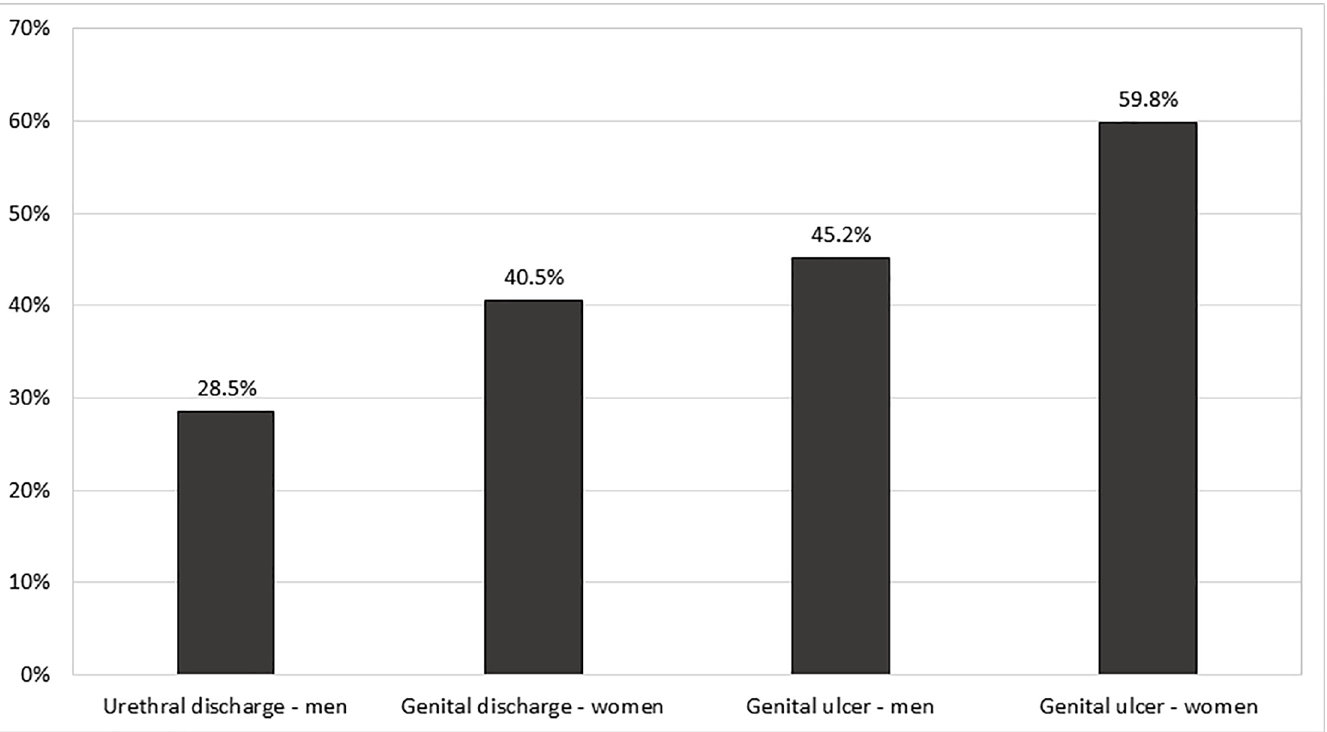
Fig 1. Prevalence of HIV-1 infection in sexually transmitted infection (STI) clinic patients, by sex and STI syndrome, Zimbabwe– 2014–2015.